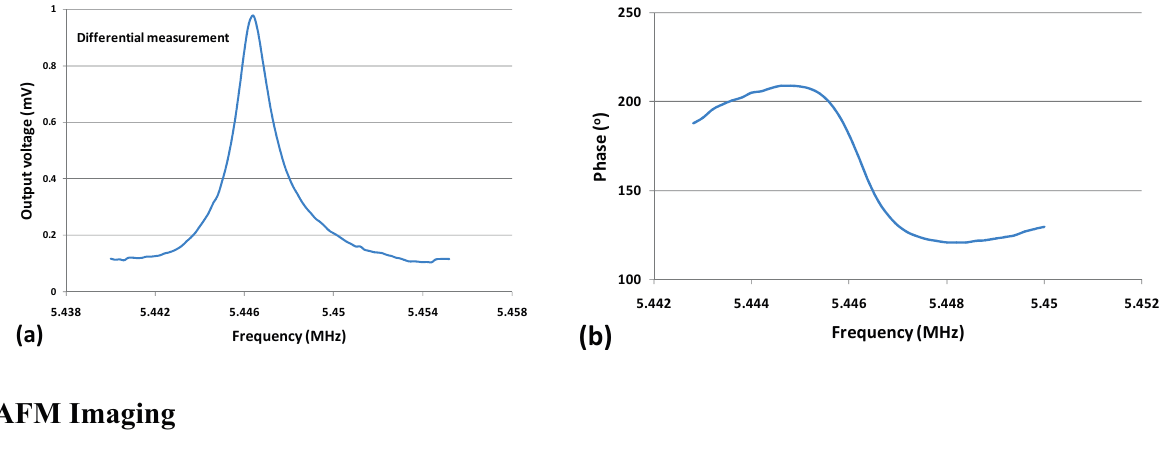
Figure 9. Output voltage ( a ) and phase ( b ) versus frequency of the differential measurement with V AC = 0.9 V. ( V DC = 3V, Measurement bandwidth = 100